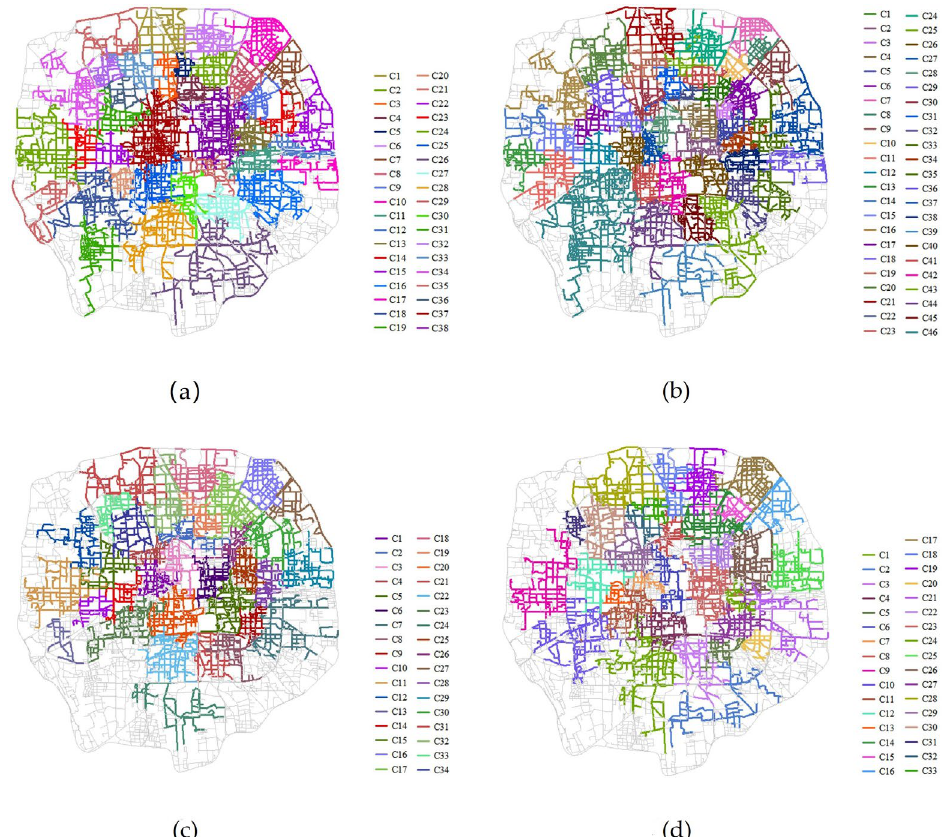
Figure 9. Low-resolution spatial communities discovered by two methods during morning rush hours: ( a ) spatial communities identified by the proposed method on Monday; ( b ) spatial commu- nities identified by Scleiden+ on Monday; ( c ) spatial communities identified by the proposed method on Sunday; ( d ) spatial communities identified by Scleiden+ on Sunday.